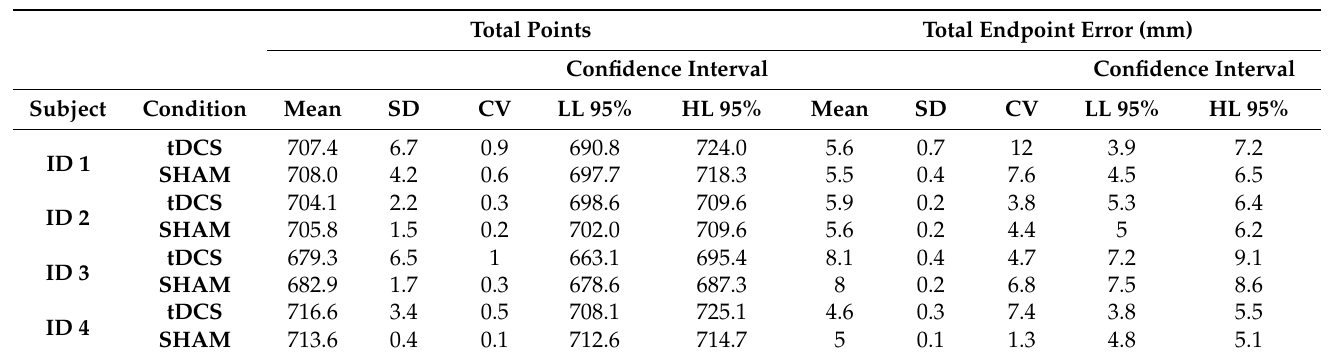
Table 2. 3-Day total points and total endpoint error along with the SD, CV, and confidence intervals for DLPFC-tDCS and SHAM conditions. Total Points Total Endpoint Error (mm) Confidence Interval Confidence